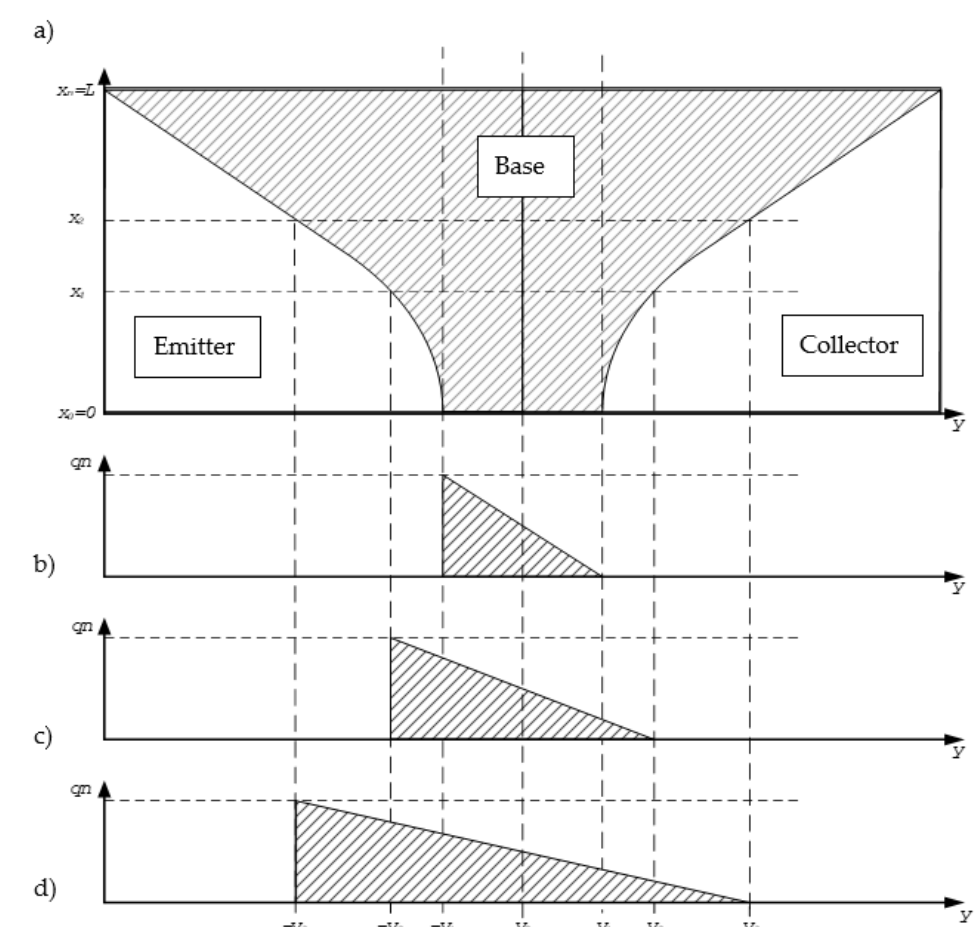
Figure A1. Comparison of carrier distributions in the base region for different values of W b ( x ) and for selected x = ( x 0 , x 1 , x 2 ). ( a ) The upper half of the base region; ( b ) the distribution for given x 1 —the slit where the base width is minimal; ( c ) the distribution for given x 2 ; ( d ) the distribution for given x 3 .